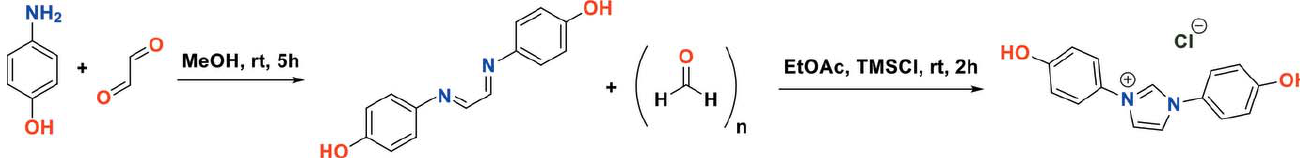
Figure 1 Synthesis of IOH (cid:2) Cl.